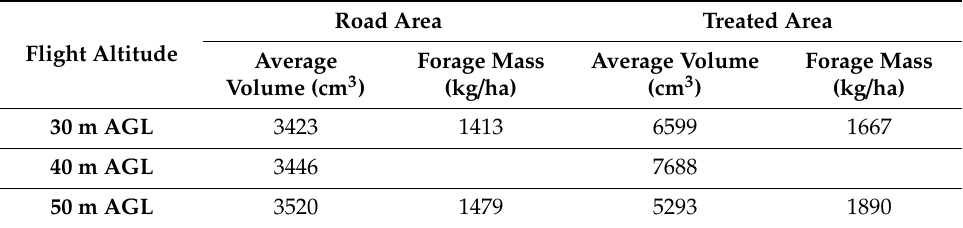
Table 2. Average volumes (cm 3 ) and forage mass estimates (kg / ha) for the road and treated areas in our study area. We did no estimate values for the 40 m AGL as our observed data was outside the minimum observed value for the